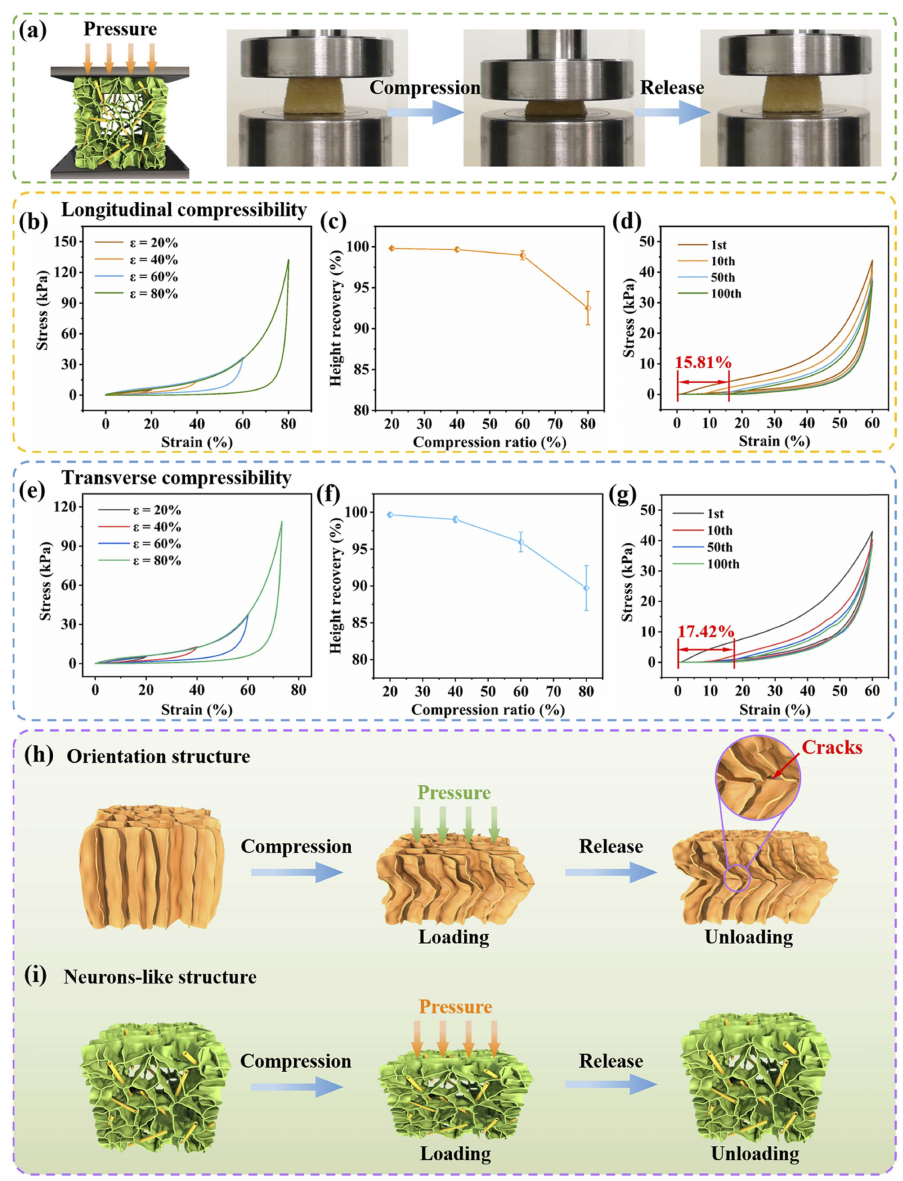
Figure 15. ( a ) The compression process of M-PCF/CS. Longitudinal compressibility: ( b ) Compressive stress versus strain curves for the M-PCF/CS with various maximum strains. ( c ) Height recovery ratio versus compression strain. ( d ) 100 cyclic compressions at a constant strain of 60%. Transverse compressibility: ( e ) Compressive stress versus strain curves for the M-PCF/CS with various maxi- mum strains. ( f ) Height recovery ratio versus compression strain. ( g ) 100 cyclic compressions at a constant strain of 60%. Comparison of compression recovery performance between ( h ) materials with orientation structure and ( i ) M-PCF/CS with neurons structure. Reproduced with permission [177]. Copyright 2022, Elsevier